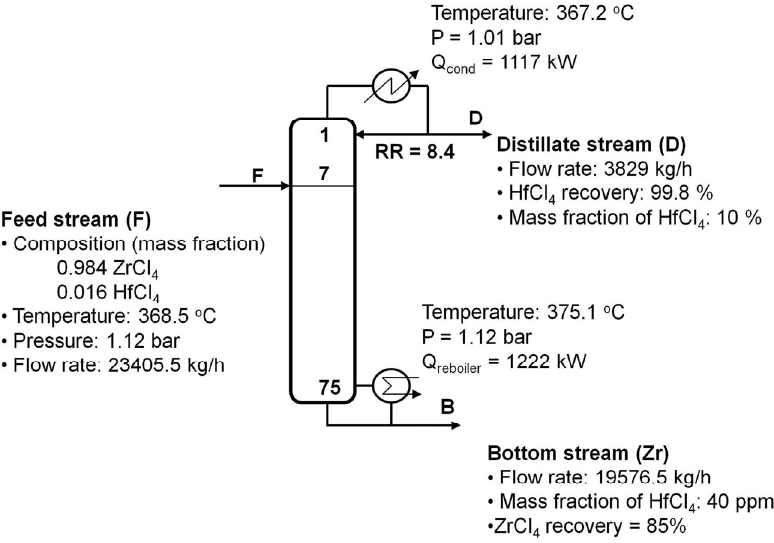
Figure 5. Optimal design of extractive distillation column the molten salt system (34.0% NaCl and KCl (8:29 M); 66.0 mol% ZrCl 4 and HfCl 4